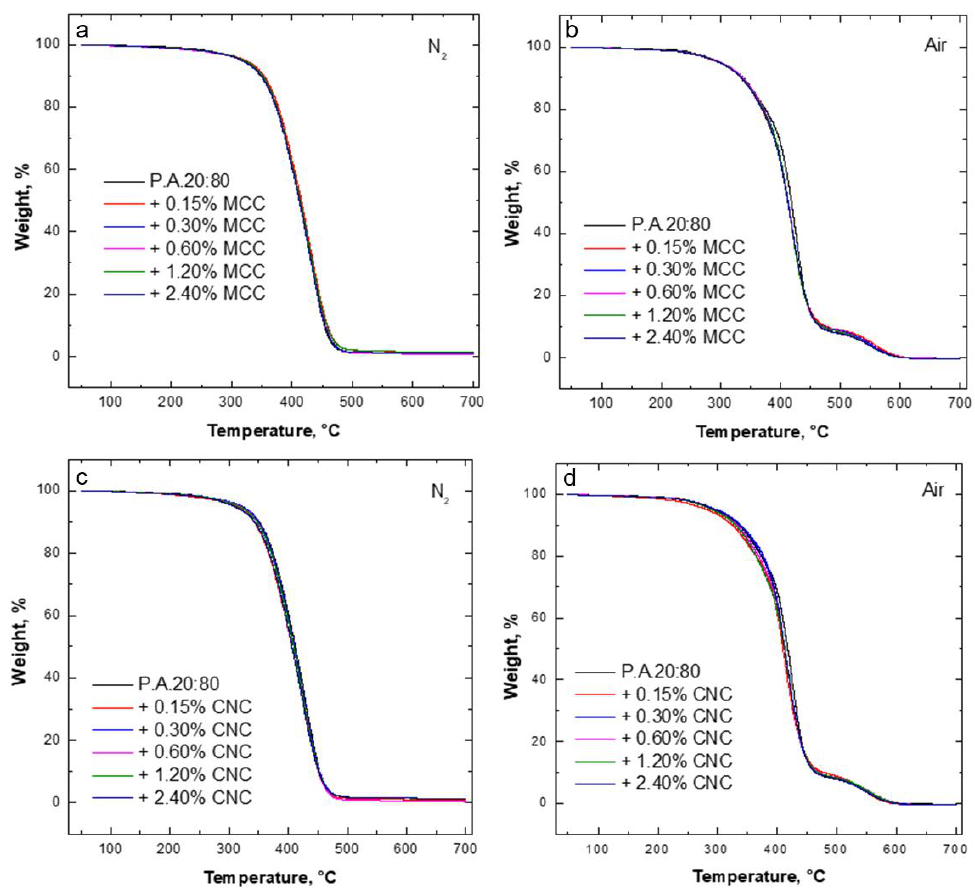
Figure 7. Thermogravimetric curves of the resin mixture containing 80 wt.% AESO with varying concentrations of MCC ( a , b ) and CNC ( c , d ) in air and N 2 heated at a constant rate of 10 °C·min −1 .